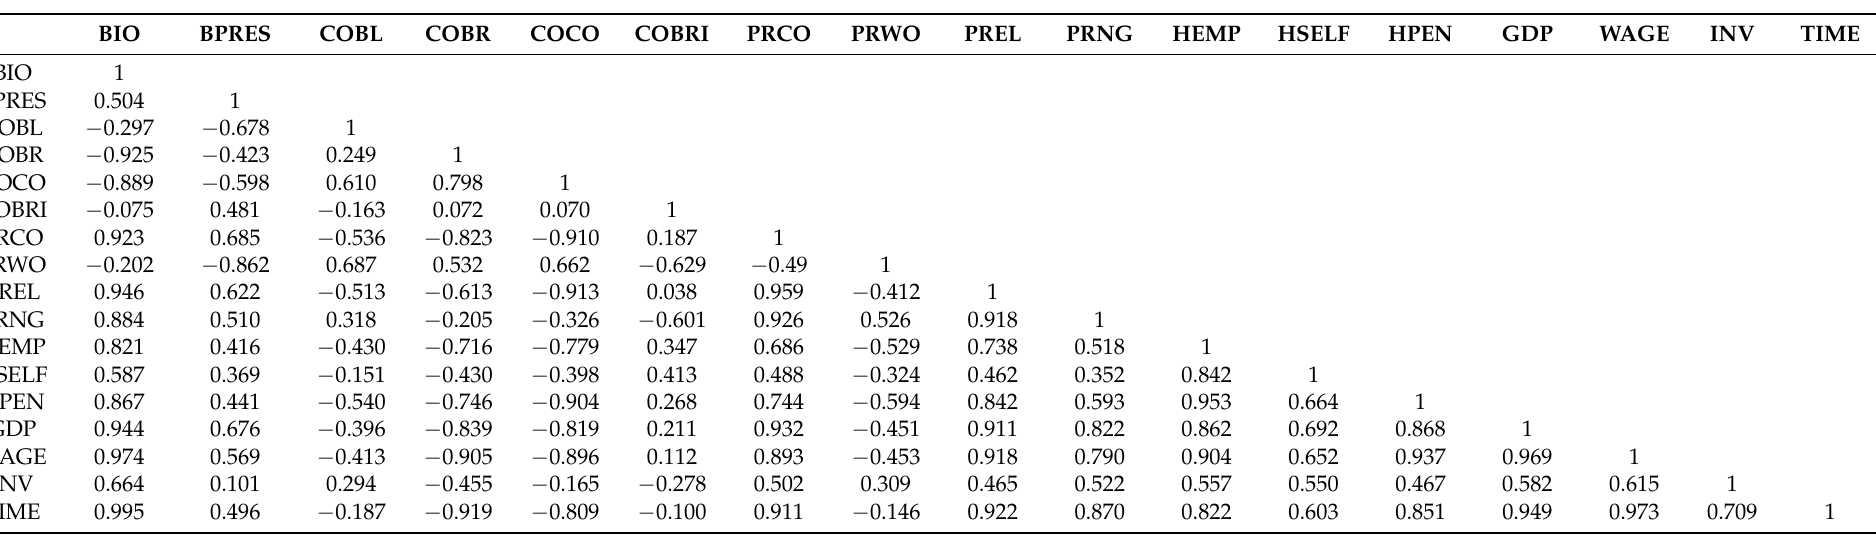
Table 4. Correlation